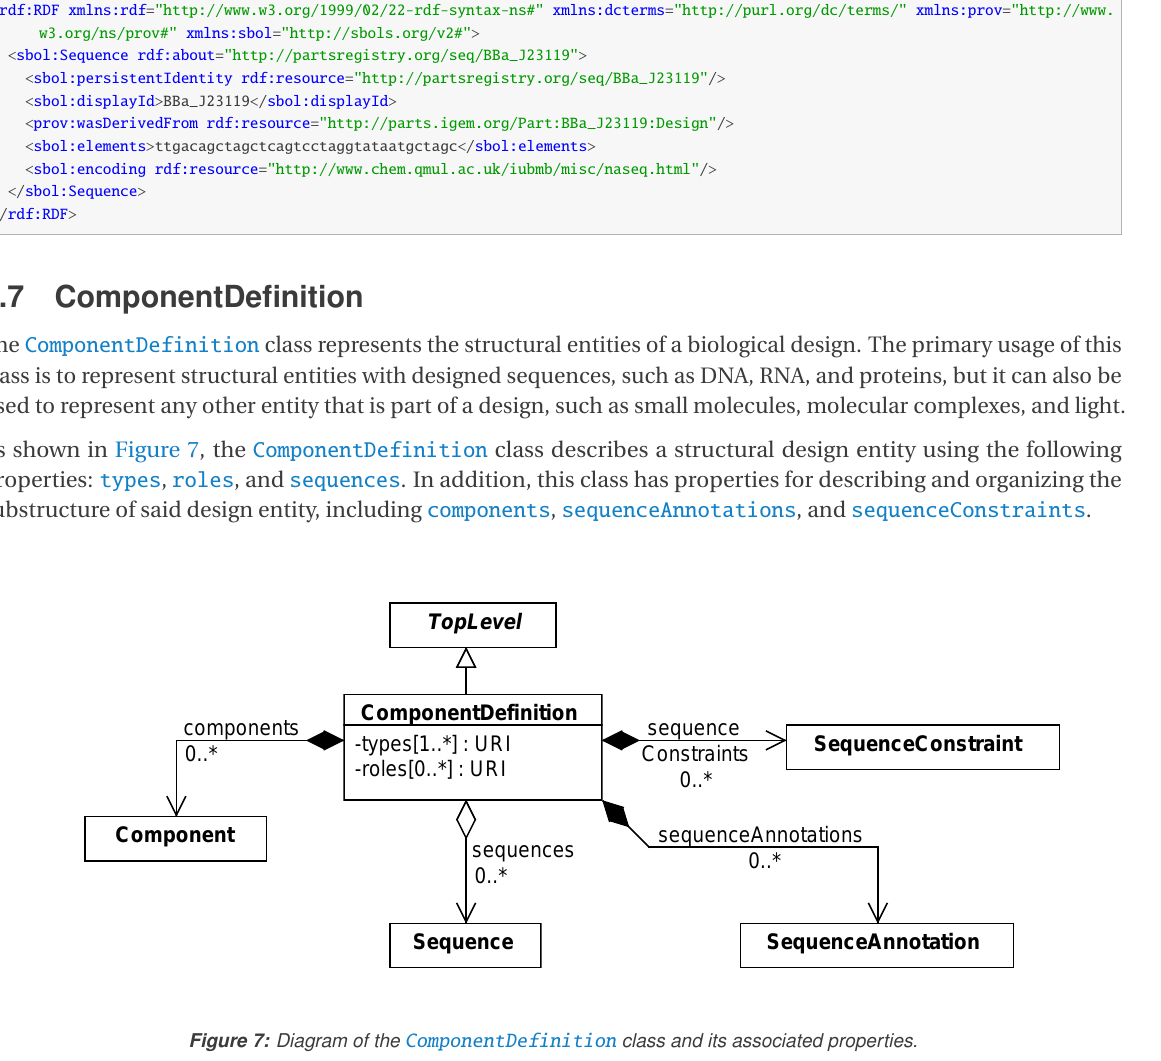
Figure 7: Diagram of the ComponentDefinition class and its associated